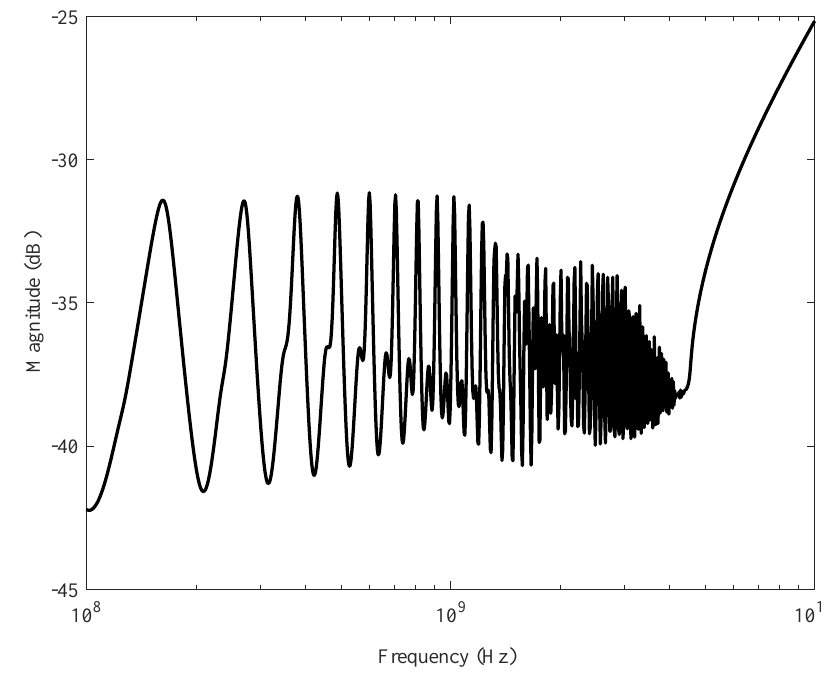
Figure 7. Original system frequency response generated by a interconnect bus of order n =